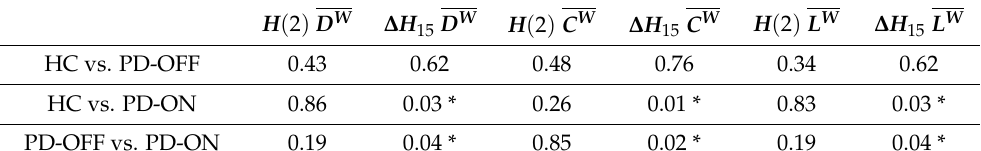
Table 3. Benjamini–Hochberg adjusted p -values. HC: healthy control, PD-OFF: Parkinson’s disease Table 3. Benjamini – Hochberg adjusted p -values. HC: healthy control, PD- OFF: Parkinson’s disease patients off medication, PD-ON: Parkinson’s disease patients on medication, D W : global node degree, patients off medication, PD- ON: Parkinson’s disease patients on medication, 𝐷 𝑊 ̅̅̅̅̅ : global node de- C W : global clustering coefficient, L W : global path length, *: p values smaller than 0.05. gree, 𝐶 𝑊 ̅̅̅̅ : global clustering coefficient, 𝐿 𝑊 ̅̅̅̅ : global path length, *: p values smaller than 0.05.